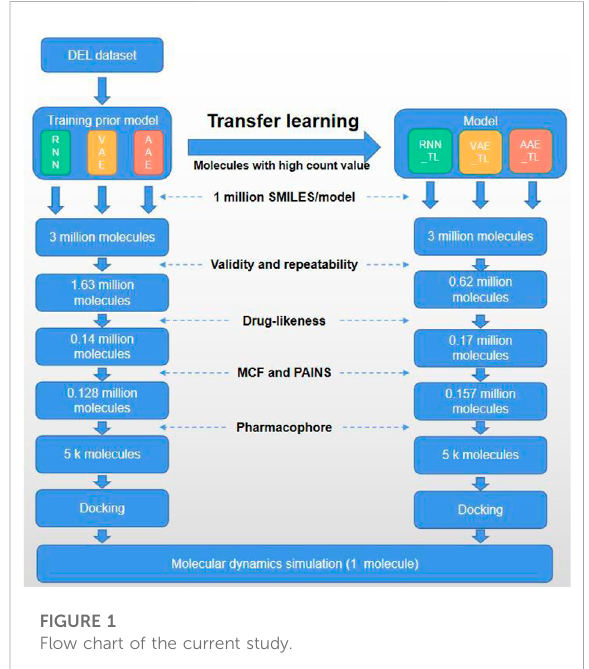
FIGURE 1 Flow chart of the current